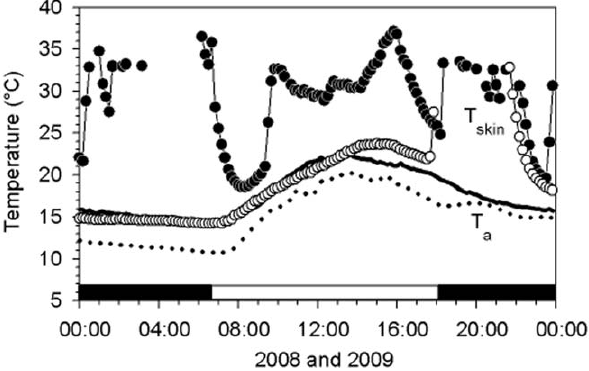
Figure 1. T skin of two different individual N. bifax and T a showing different patterns of torpor. The patterns shown are (i, T skin : open circles, T a : dotted line) an individual that remained torpid during the whole day and aroused only in the evening to possibly forage, and the second pattern shows (ii, T skin : closed circles, T a : smooth line) an individual displaying the typical morning and afternoon bouts of torpor along with an additional torpor bout during the night. The horizontal black and white bars at the bottom of the graphs represent night and day, respectively.